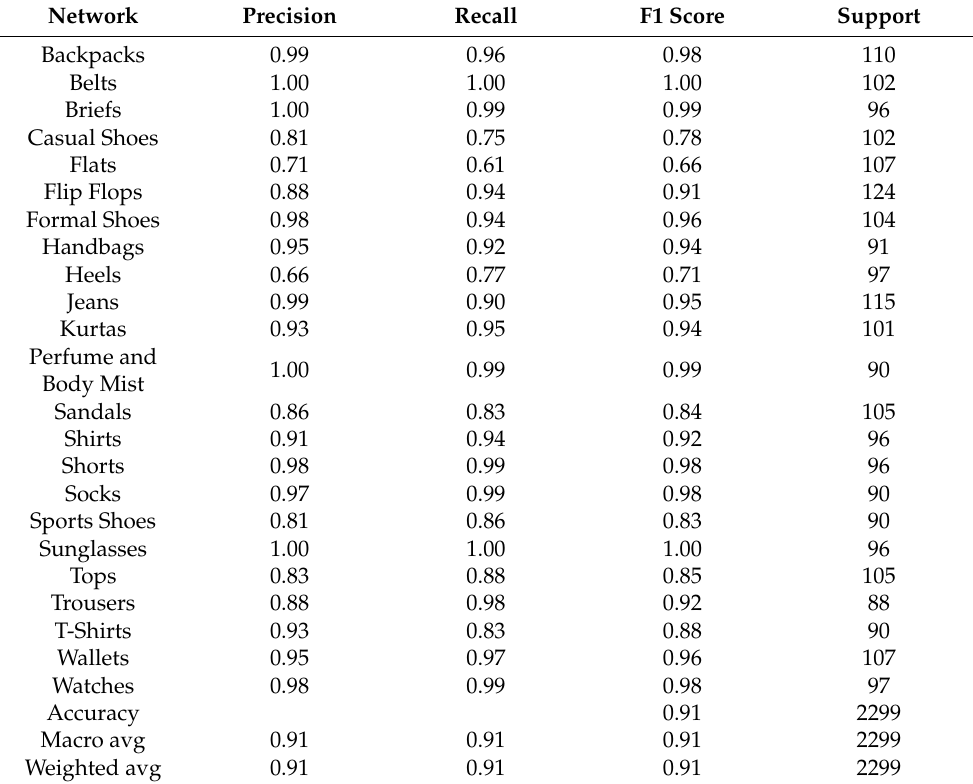
Table 8. Classification report of the GoogLeNet